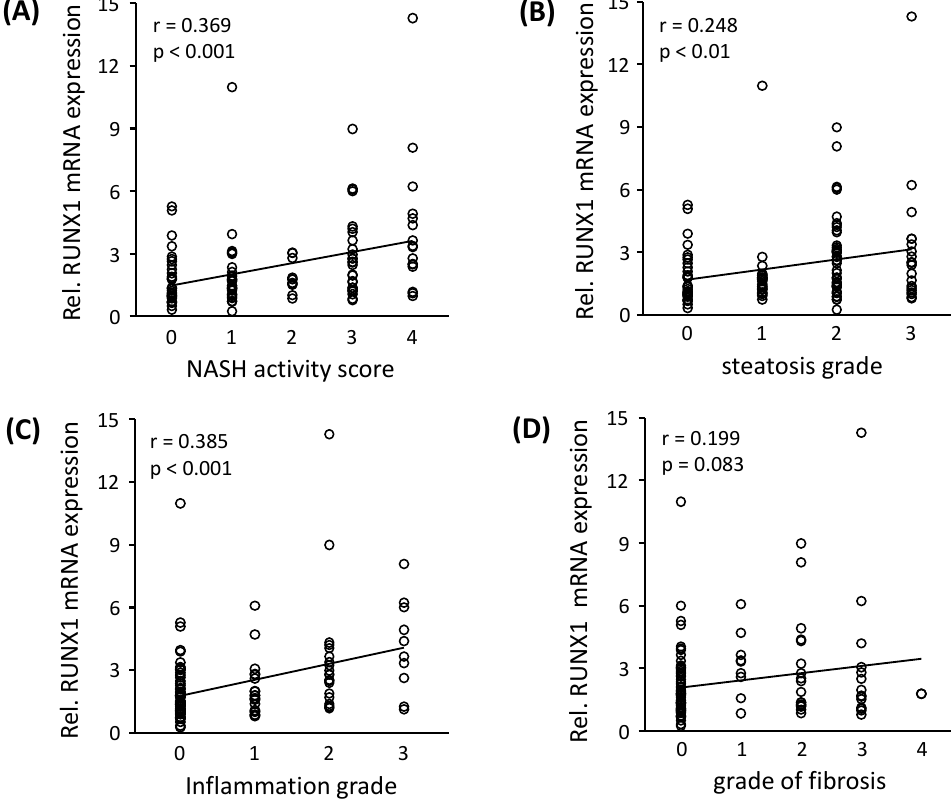
Figure 1. Correlation between RUNX1 mRNA expression and histopathological parameters. Expression of RUNX1 mRNA was analyzed by qRT-PCR in liver tissue samples from patients with NASH ( n = 43), hepatic steatosis ( n = 46) and normal liver tissue ( n = 33) and correlated to histopathologic proven ( A ) NASH activity score ( B ) steatosis grade ( C ) inflammation grade and ( D ) fibrosis grade. HPRT mRNA expression was determined for normalization, statistical di ff erences between several grades were analyzed by Kruskal-Wallis Test ( p < 0.05 was considered significant) and ‘r’ denotes the Pearson’s correlation coefficient.